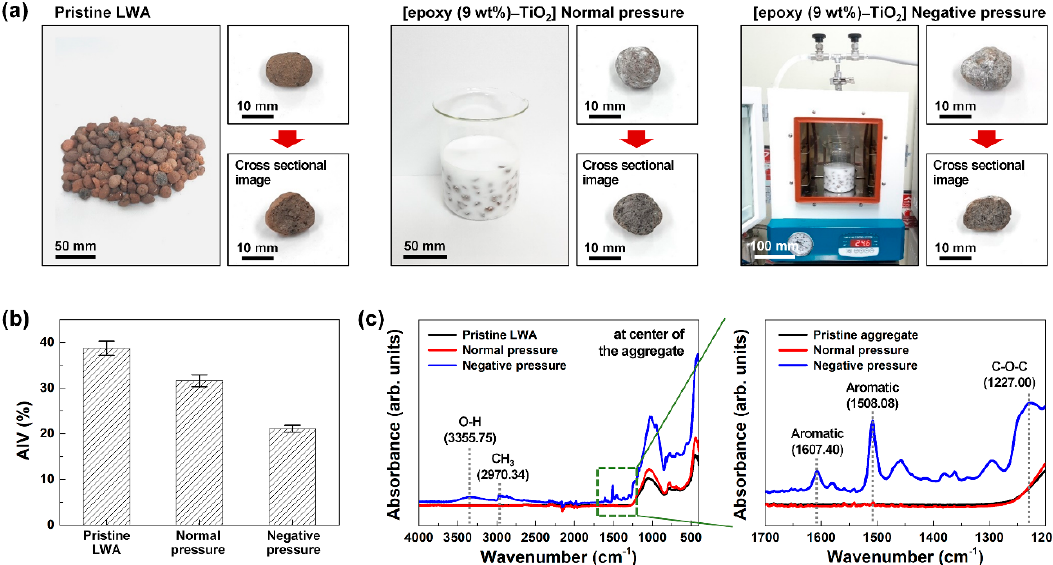
Figure 2. Comparison of LWA properties according to coating conditions. ( a ) Surface and cross-section images, ( b ) aggregate impact value, ( c ) ATR–FTIR spectra of LWA cross-section of pristine LWA, LWA coated with epoxy–TiO 2 under normal pressure, and LWA coated with epoxy–TiO 2 under negative pressure.